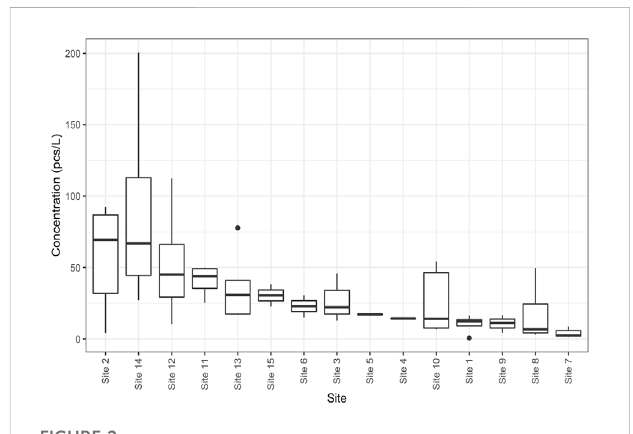
FIGURE 2 Boxplots of blank-corrected concentrations of microplastics in stormwater from